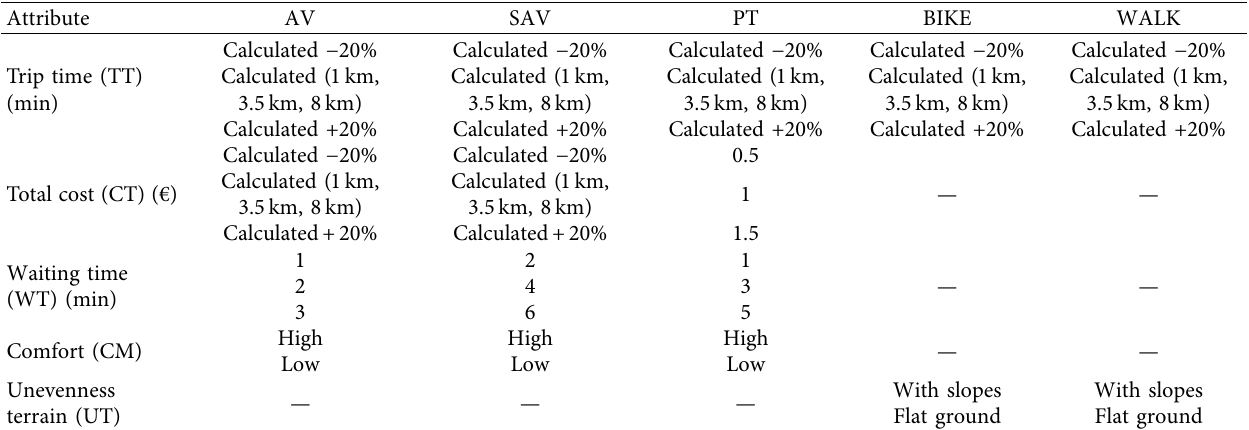
Table 2: Selected attributes and their levels in the SP design.